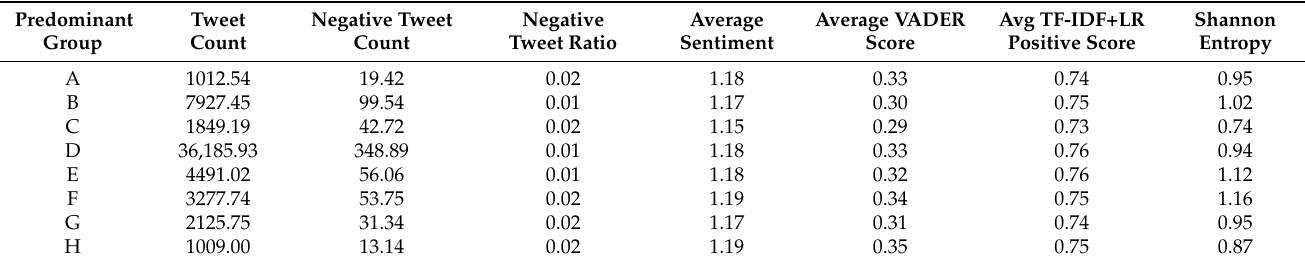
Table 5. Predominant London Output Area Classification (LOAC) groups and sentiments. Predominant